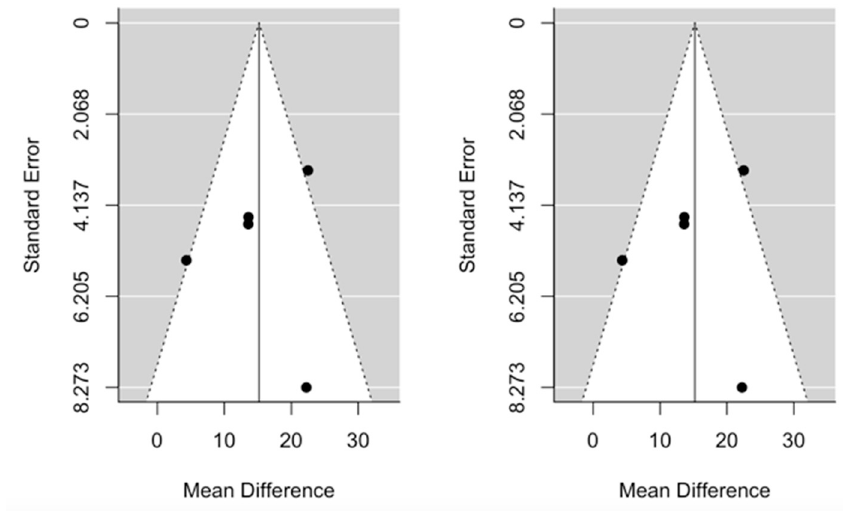
Figure 5. Funnel plots for mean difference in post recurrence survival. Left: original data; Right: imputation of missing studies.